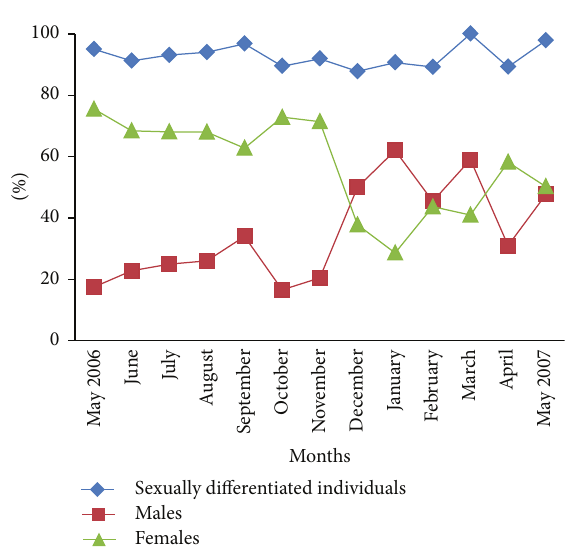
Figure 2: Monthly proportions of sexually differentiated individu- als, females, and males from May 2006 to May 2007.